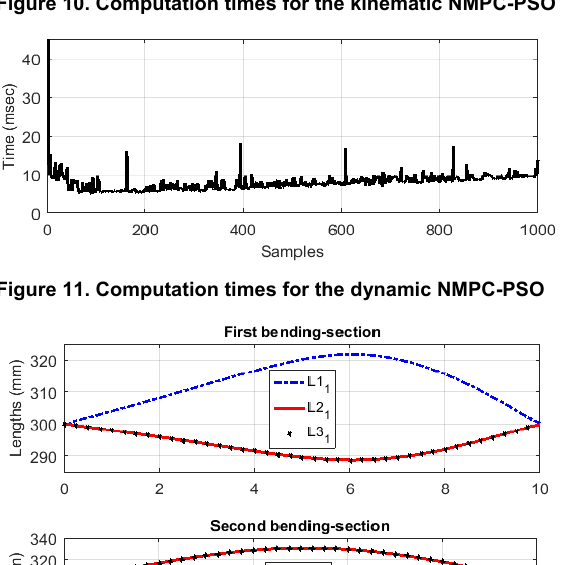
Figure 10. Computation times for the kinematic NMPC-PSO